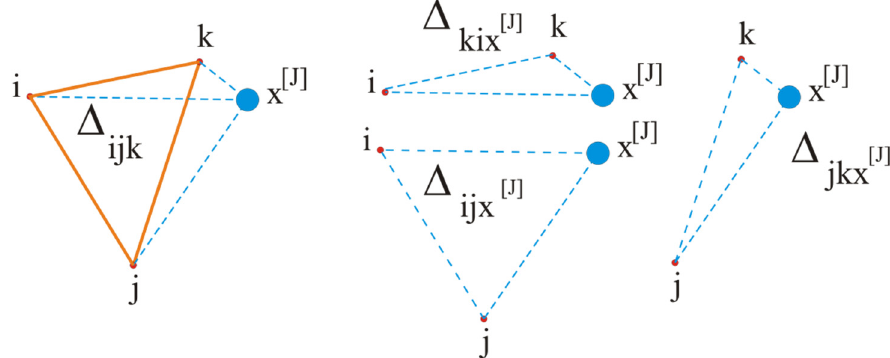
Figure 2. Flexible contact model triangular shape functions at local contact point x i [ J ]